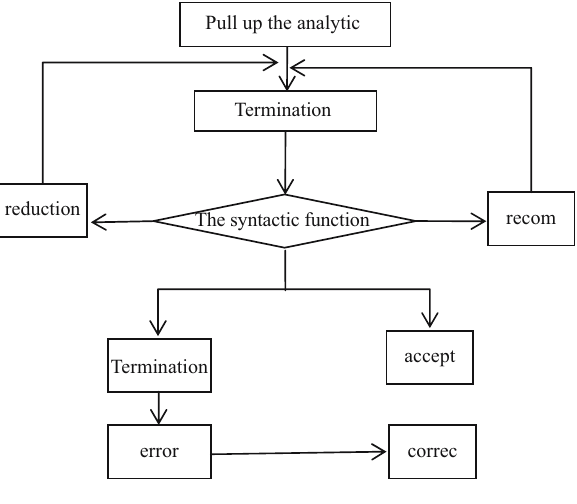
Figure 1: Algorithm correction fl